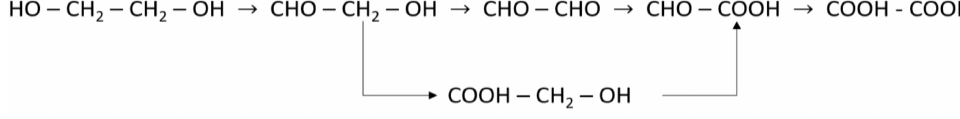
Figure 6. Mechanism of ethylene glycol oxidation to C 2 intermediates based on